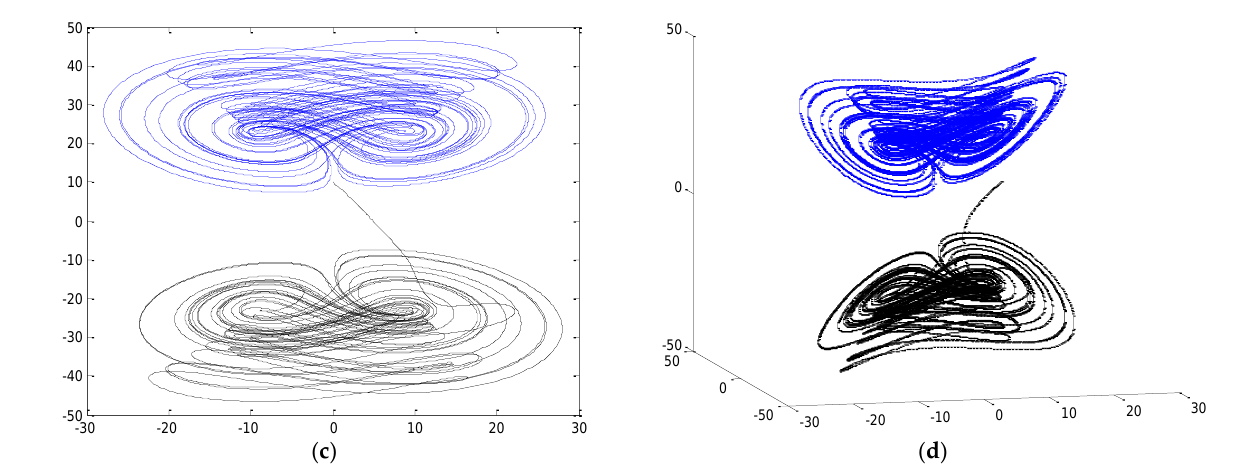
Figure 11. The phase portraits for the anti-synchronization between Chen (Black Line) and Lorenz chaotic systems (Blue Line) with 𝛼 𝑖 = 0.9,𝑖 = 1,2,and 3 , and time delay 𝜏 = 5 s: ( a ) On (𝑥 − 𝑦,𝑥 1 − 𝑥 2 ) phase plane; ( b ) on (𝑥 − 𝑧,𝑥 1 − 𝑥 3 ) phase plane; ( c ) on (𝑦 − 𝑧,𝑥 2 − 𝑥 3 ) phase plane; ( d ) on (𝑥 − 𝑦 vs.𝑧,𝑥 1 − 𝑥 2 − 𝑥 3 ) space.